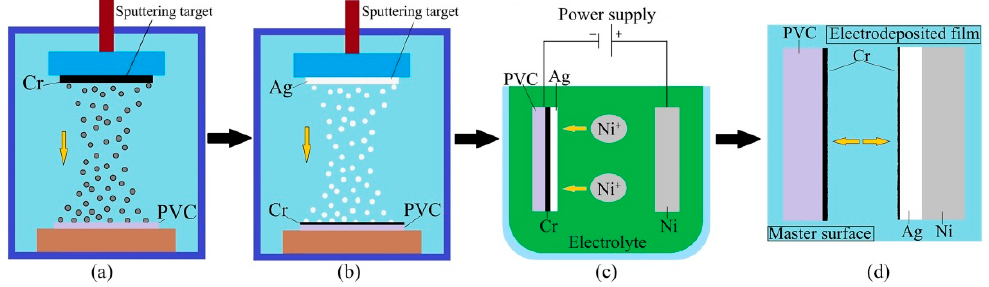
Figure 1. Experimental process. ( a ) Formation of release layer; ( b ) Formation of conductive Ag layer; ( c ) Formation of electrodeposition film; ( d ) Demoulding.